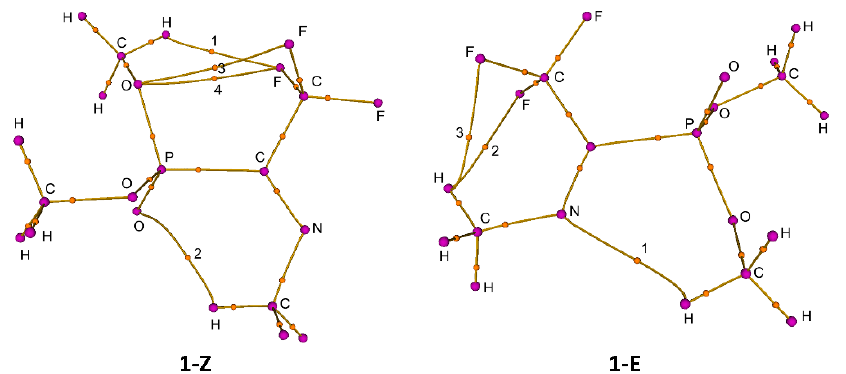
Figure 4. Bond-critical points of type (3, − 1) (CPs) for 1-Z and 1-E . Figure 5. Charges on the atoms in compounds 1 and 3, calculated by the NBO method.